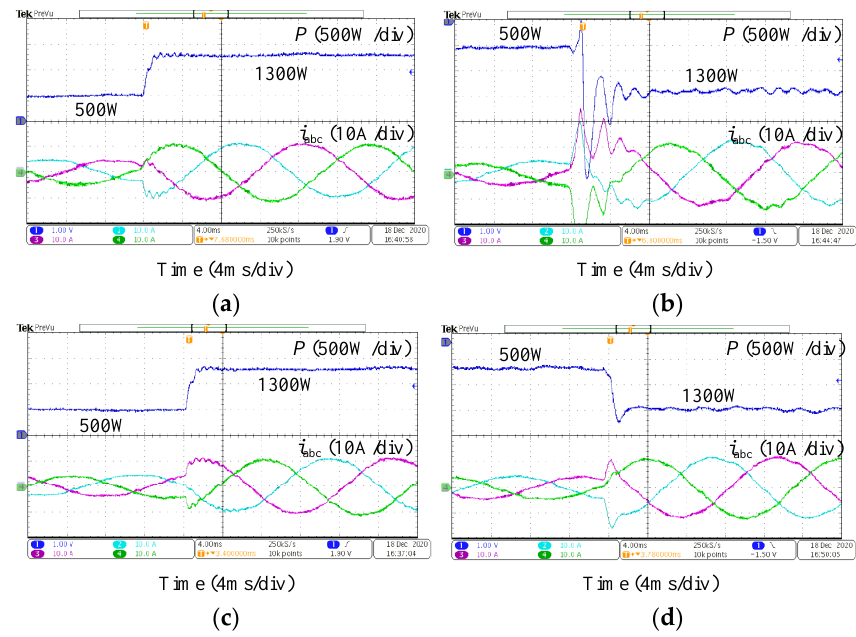
Figure 20. Experimental results as P changes, with U d = 80 V. ( a ) Conventional control under forward power flow. ( b ) Conventional control under reverse power flow. ( c ) IRSE control under forward power flow. ( d ) IRSE control under reverse power flow.